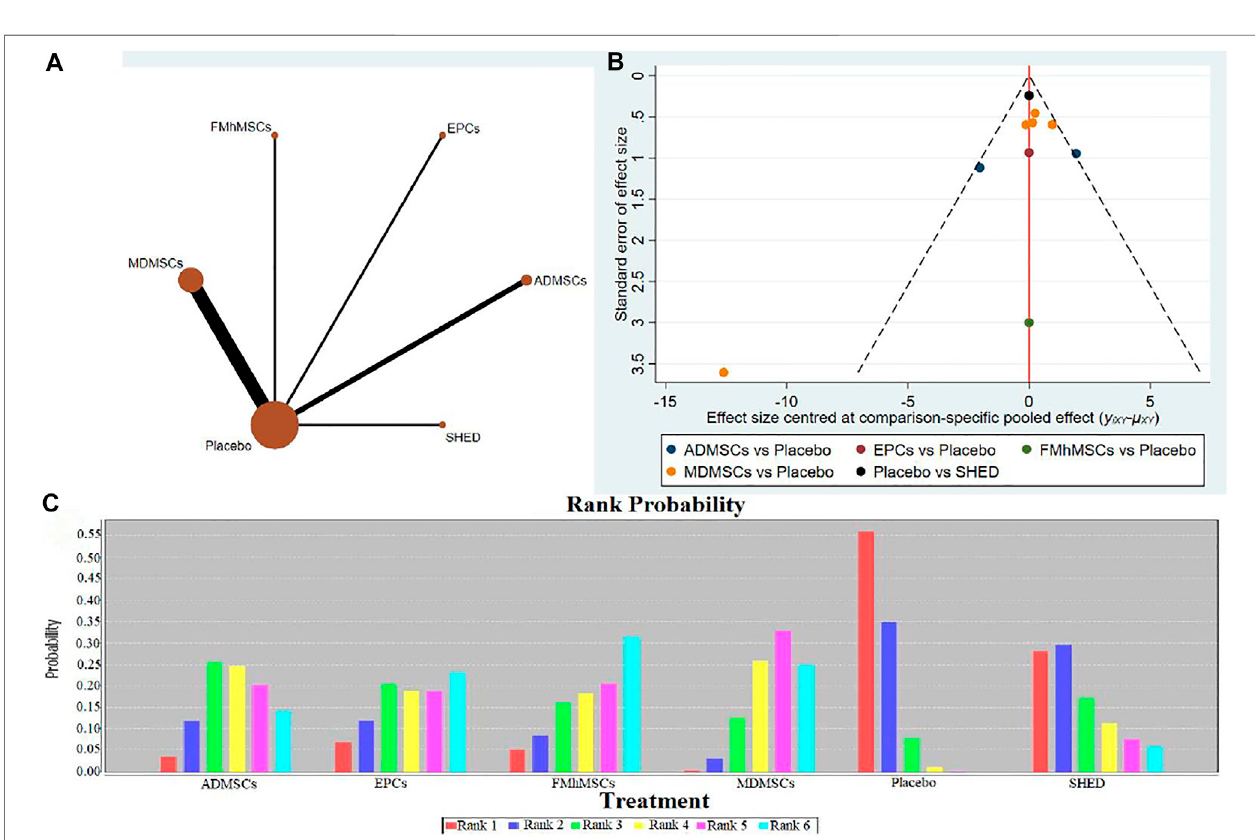
FIGURE 9 | Network Meta-analysis of renal histopathological changes (A) Evidence network diagram; (B) The comparison-correction funnel plot; (C) The ranking results).